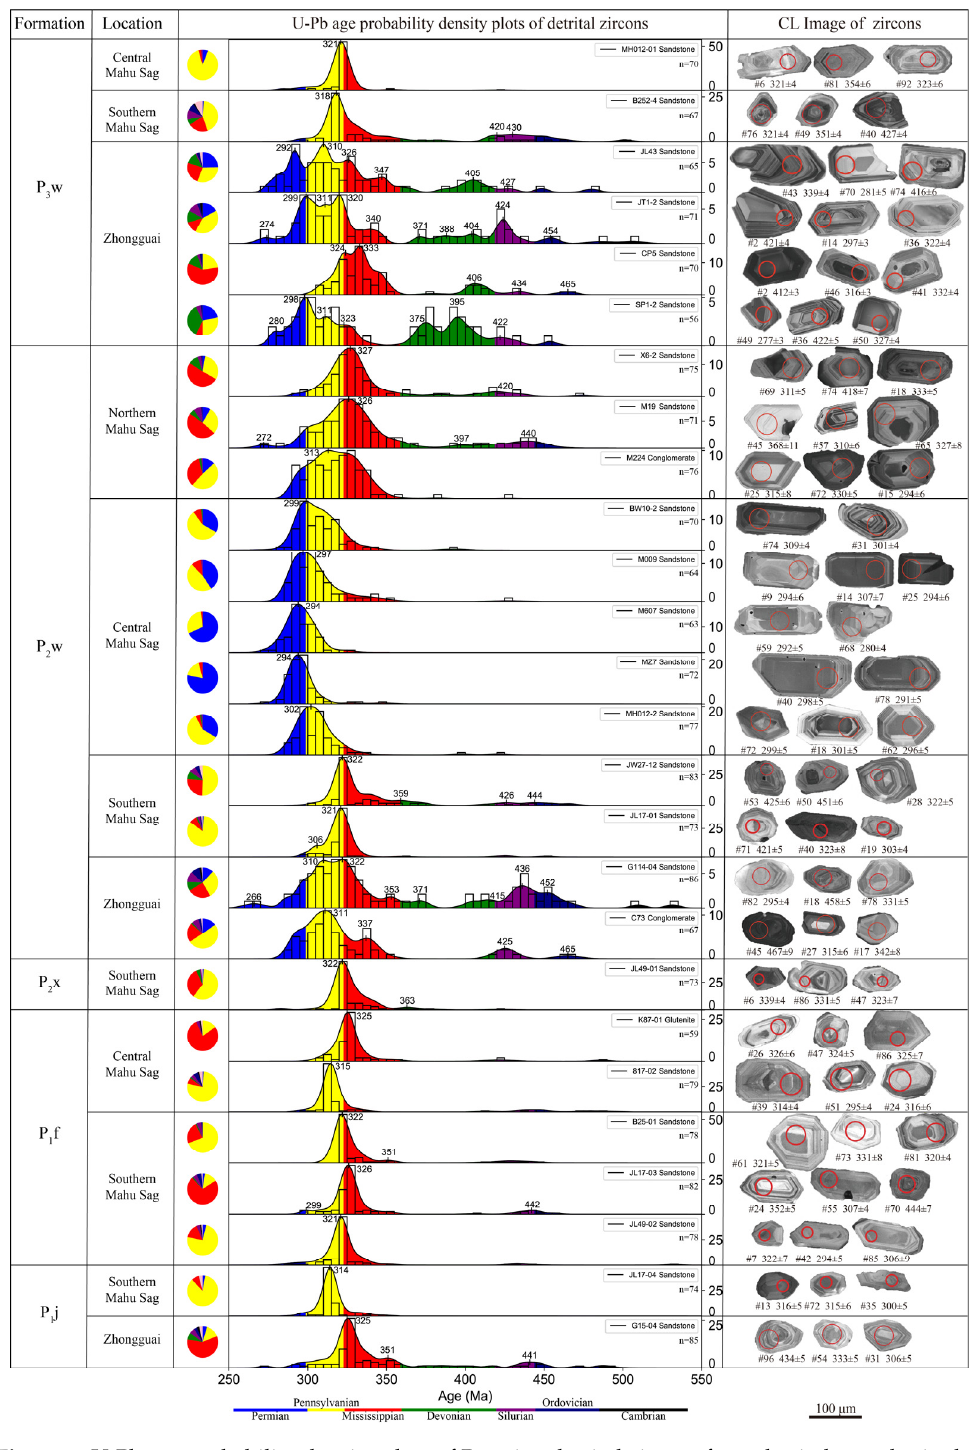
Figure 6. U-Pb age probability density plots of Permian detrital zircons from detrital samples in the Mahu-Zhongguai area, northwestern Junggar Basin. The age distribution is shown by a pie chart on the left for each sample. The cathodoluminescence images of some detrital zircon samples are shown in the rightmost column. The locations and details of detrital zircon samples are shown in Figure 1 and listed in Table 1.